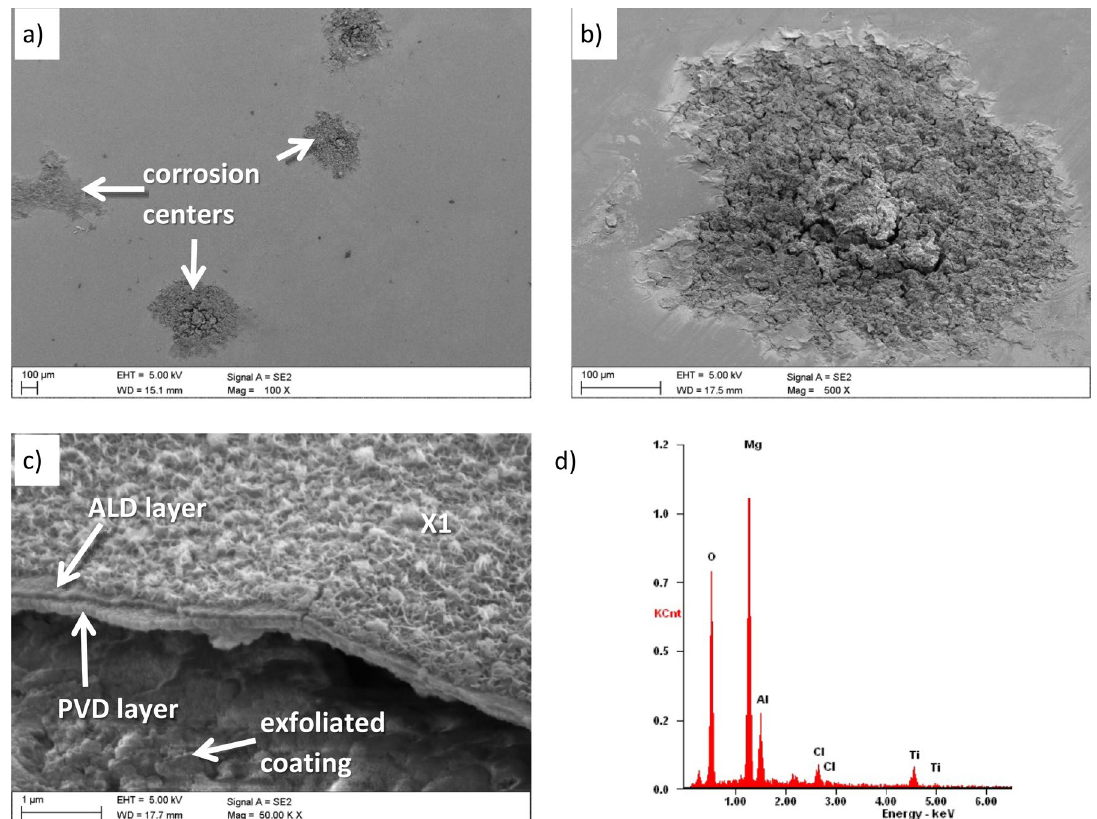
Figure 12. ( a – c ) Surface morphology of Ti + TiO 2 /Al 2 O 3 + TiO 2 coating on the AE42 alloy substrate after corrosion process, ( d ) X-ray energy dispersive plot of the area X1 shown in ( c ).